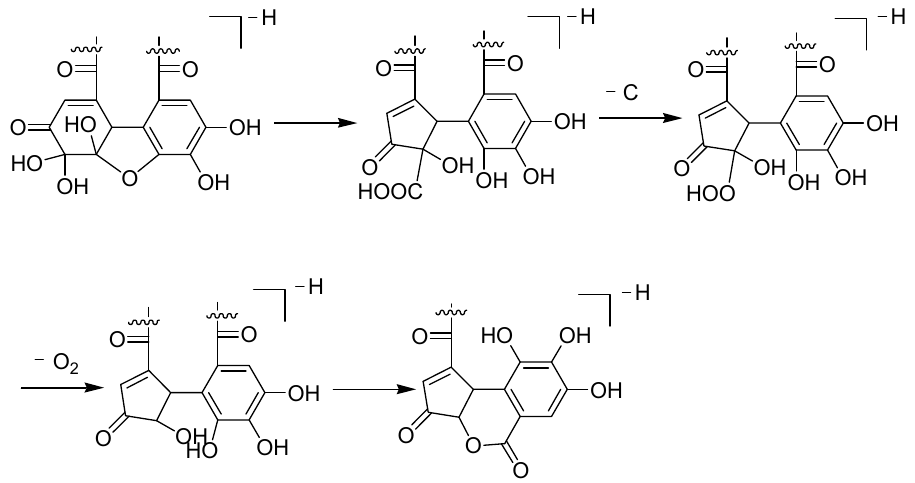
Figure 4. Proposed decarboxylation route of the DHHDP moiety.